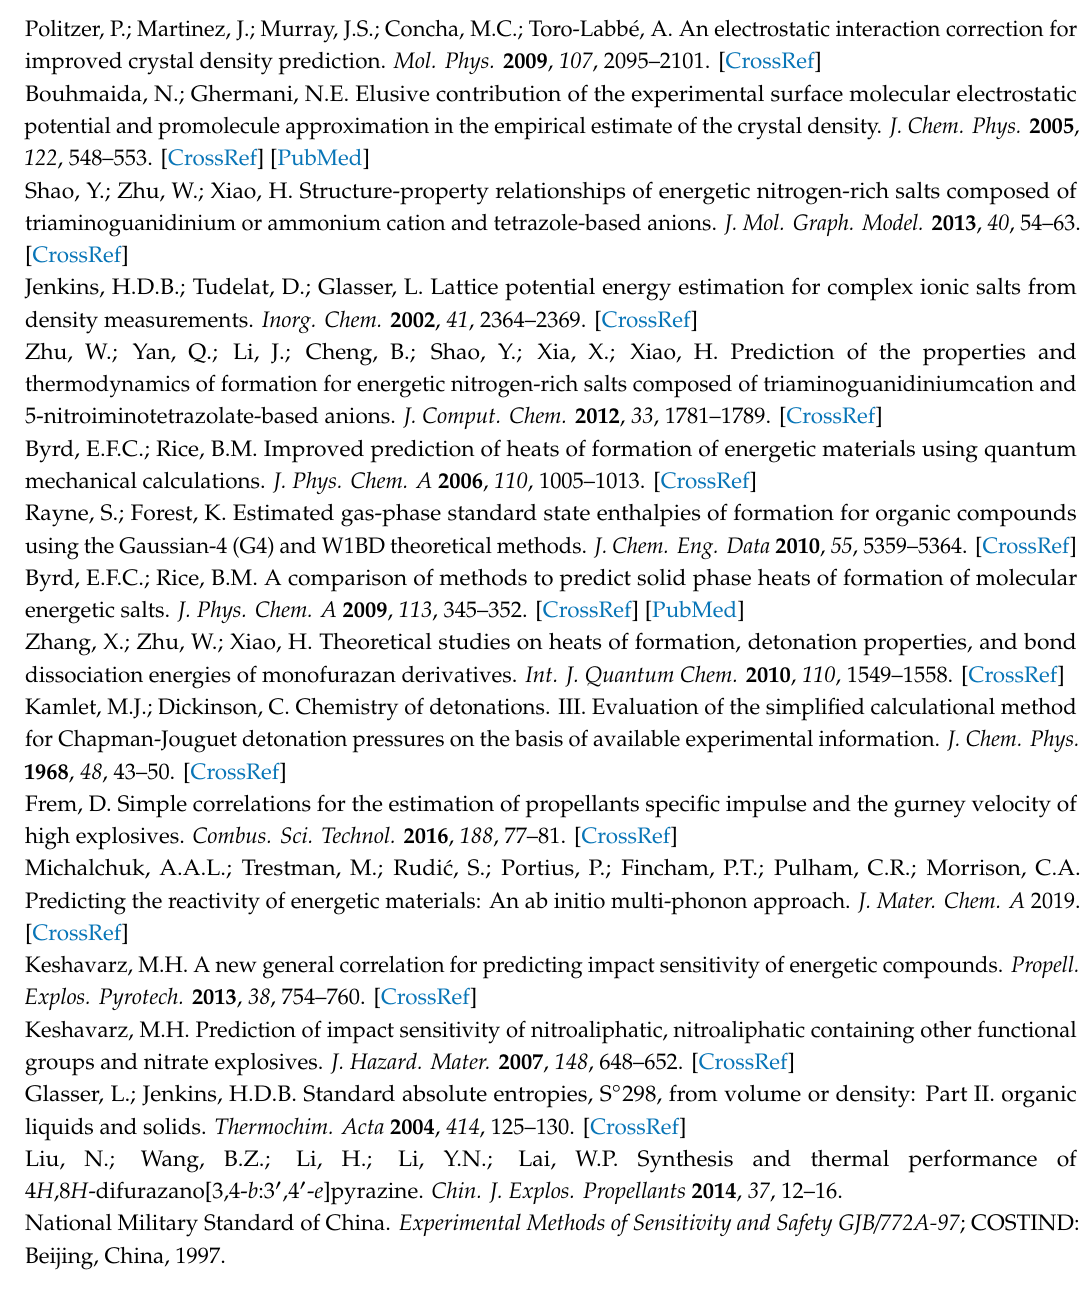
Sample Availability: Samples of the compound triaminoguanidinium 4,8-dihydrodifurazano[3,4- b , e ]pyrazine are available from the